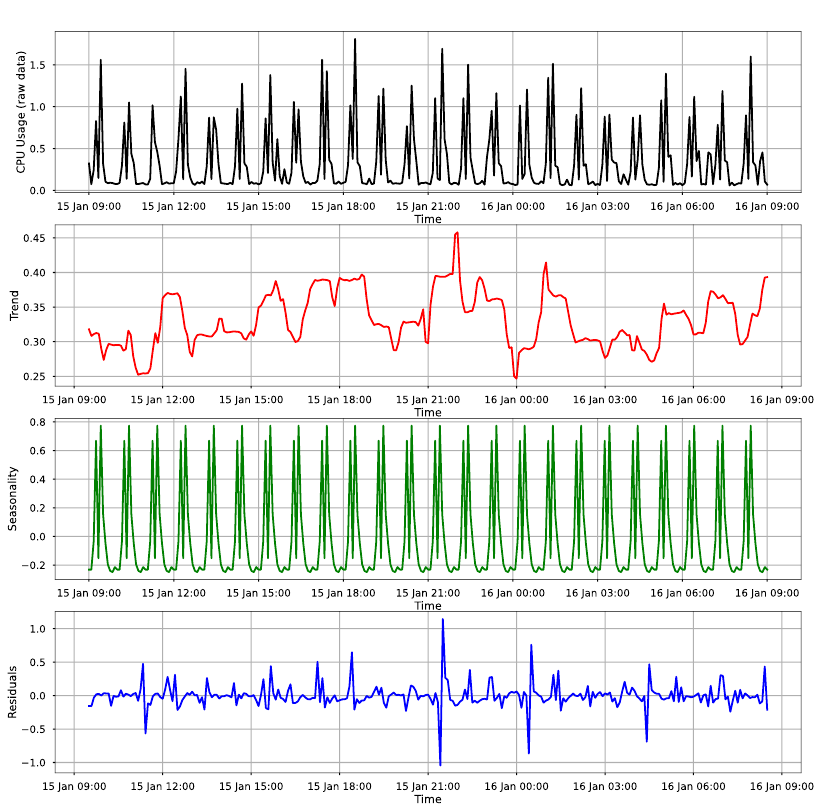
Figure 2. Decomposition (weekday)